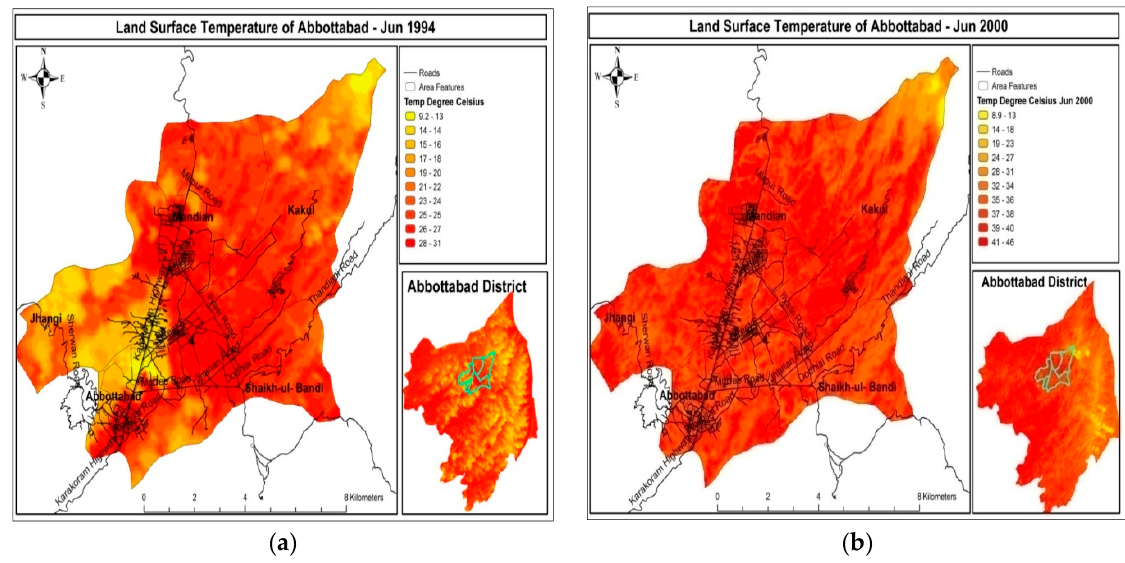
Figure 11. ( a ). LST of Abbottabad from Jun 1990–1994 ( b ) LST of Abbottabad from Jun 1995–2000.